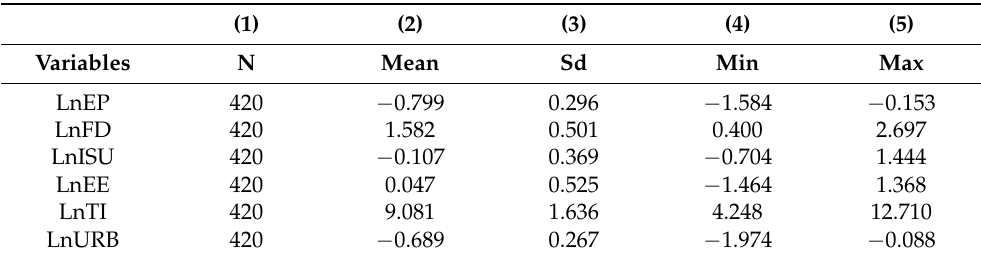
Table 1. Descriptive statistical analysis of variables.